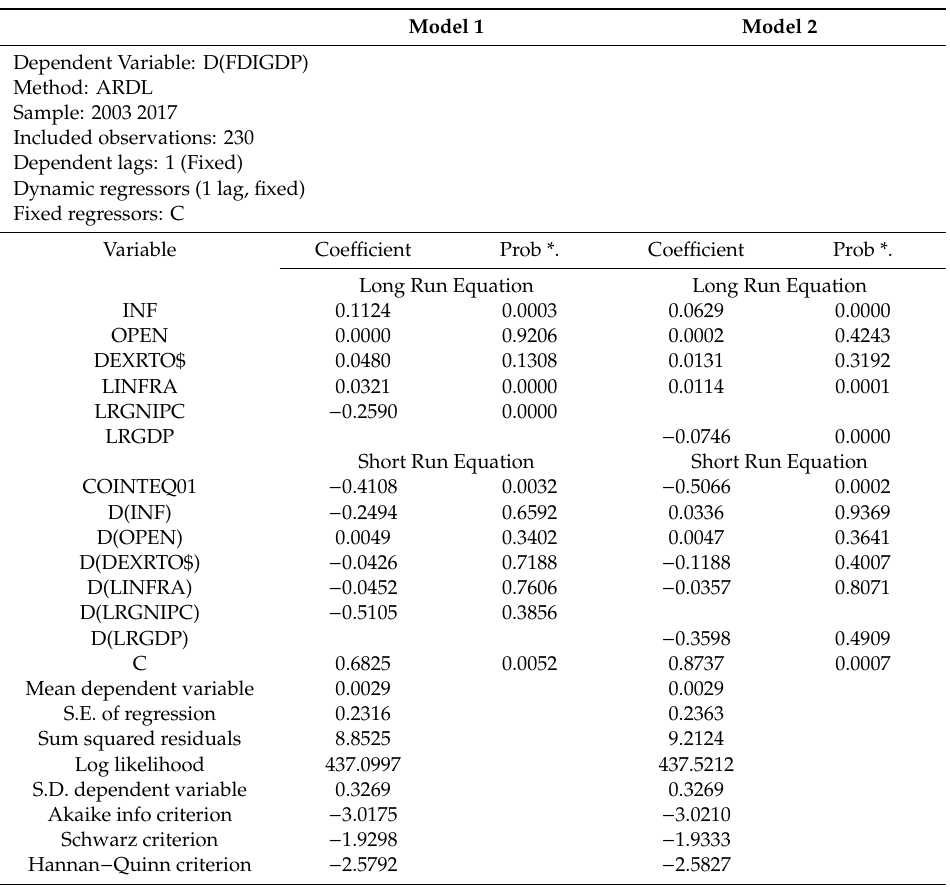
Table 5. Summary of Auto-Regressive Distributed Lag (ARDL) models estimated with FDI / Gross Domestic Product (GDP) as the dependent variable. Source: Authors’